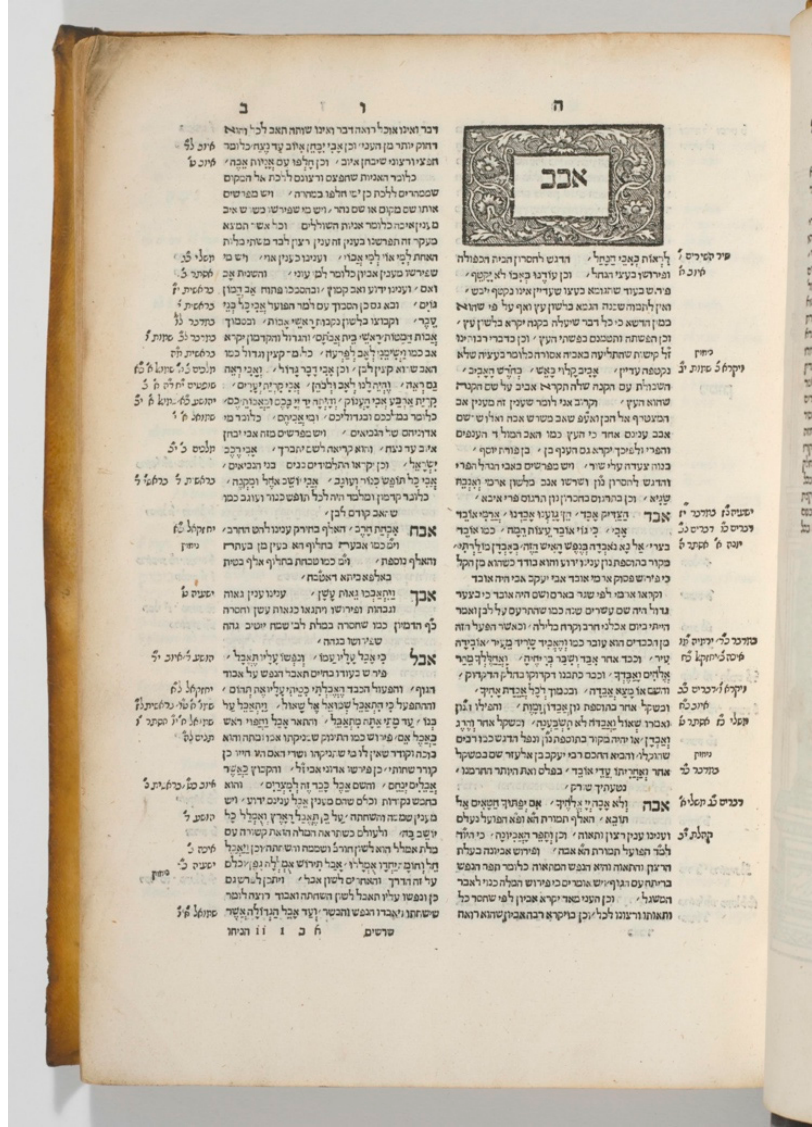
Figure 12. David Kim ḥ i, Sefer ha-Shorashim; Marsh’s Library R.2.1.34.